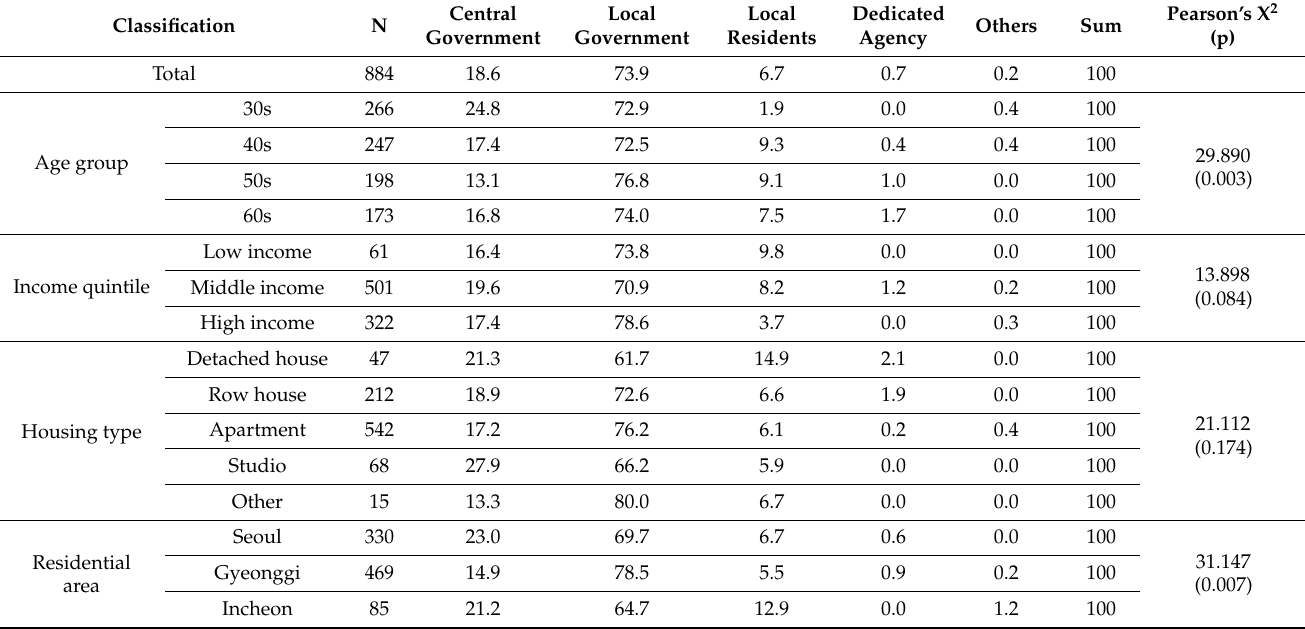
Table 13. Cross-analysis of the main management agent of street trees and demographic